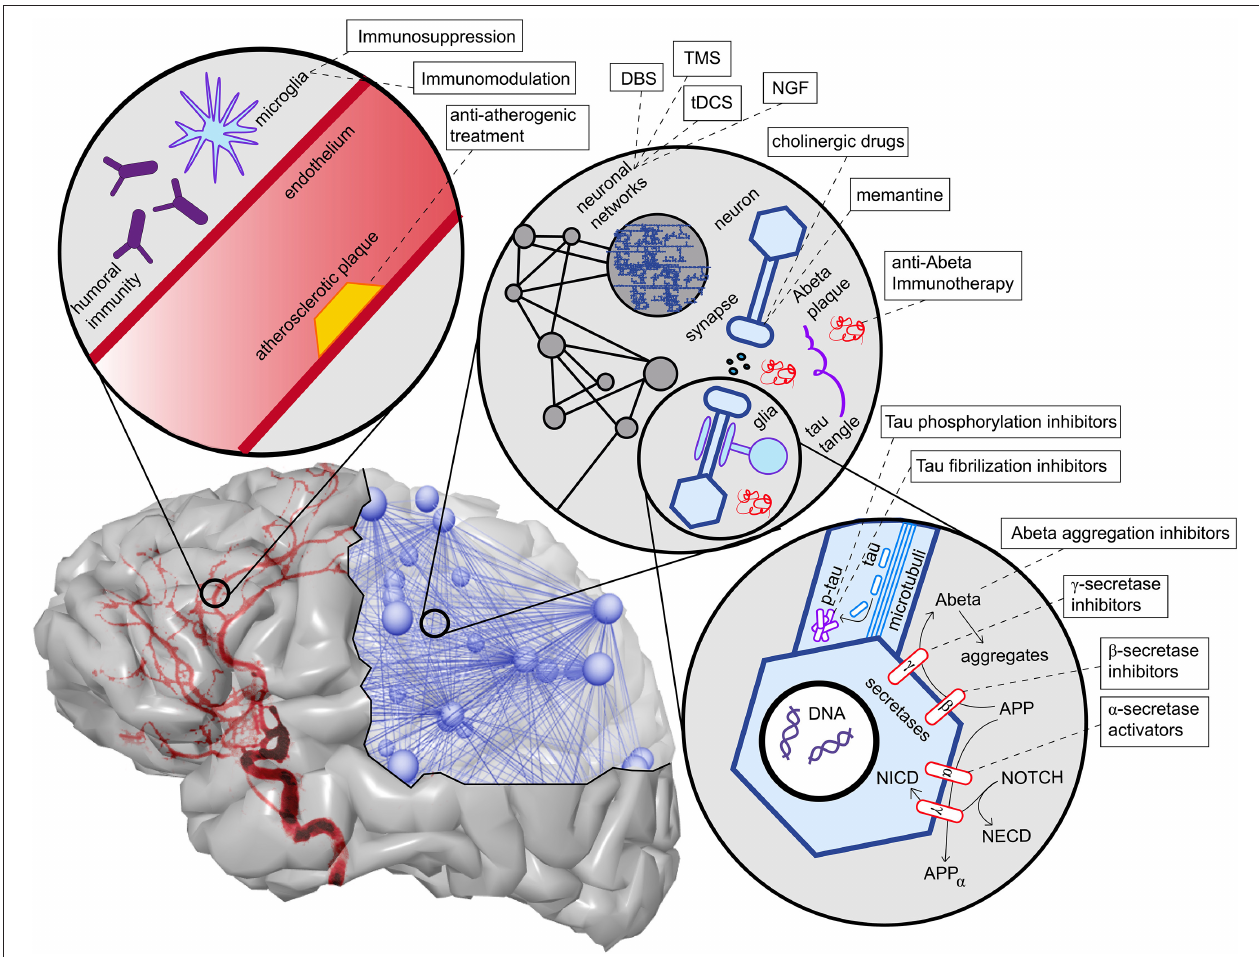
FIGURE 5 | Overview of contributing factors in AD and potential intervention strategies. Shown are only the most important factors, which are also described in more detail in this article’s main text. In the upper left corner, we see the neurovascular system. Both characteristics of blood vessels (e.g., atherosclerosis and endothelial dysfunction) (Love and Miners, 2016), as well as aspects of the blood-brain barrier (Sweeney et al., 2018), play a role in AD. A particular aspect here is the role of neural immunity, both with the brain-own microglia cells and the effect of systemic immune cells, e.g., mediated by antibodies ( Heneka et al., 2015a,c). On the upper right corner, we see an illustration of the multiscale network structure of the brain. Stimulation approaches as deep brain stimulation (DBS), transcranial magnetic stimulation (TMS), and transcranial direct current stimulation (tDCS) act on the larger scale of a network-level; nevertheless, the actual changes happen on the level of synapses. Also, transmitter interventions develop their effects mainly at the micro-scale of synapses. In the lower right corner, basic molecular pathways in the extra- and intracellular space of a neuron are shown. We focused here on the processing of the two hallmark proteins Abeta and Tau, as well as the Notch-1 pathway, which is involved in memory (Marathe and Alberi, 2015) and plasticity (Brai et al., 2015). We illustrate the APP procession by the amyloidogenic or non-amyloidogenic way and its interaction with Notch-1 processing and, second, in the axon, the hyperphosphorylation and aggregation of Tau. A more detailed description of the named treatment strategies presently under development is provided in Table 1 . NGF, nerve growth factor; Abeta, amyloid-beta; p-tau, phosphorylized Tau protein; APP, amyloid precursor protein; APP α , APP in alpha-helix configuration; NECD, Notch extracellular domain; NICD, Notch intracellular